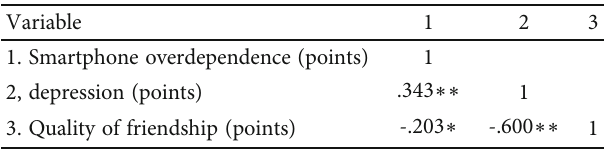
Table 3: Results of the correlation analysis among the variables.